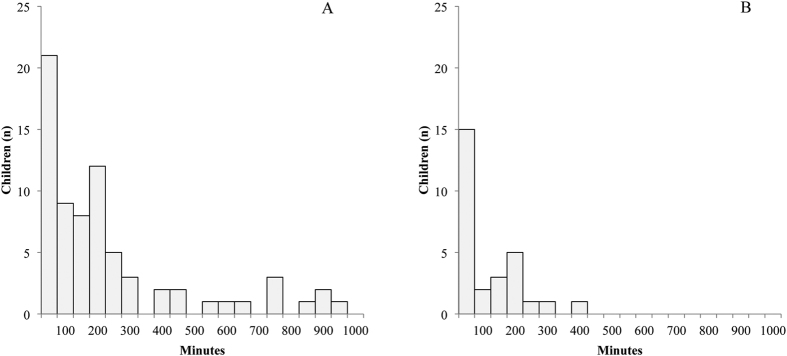
Number of children reaching high-normal and hyperglycaemic sensor glucose concentrations during specified time intervals.(A) Duration in minutes sensor glucose concentrations ≥6.7 mmol/L (n = 72; 65% of the total group) (B). Duration in minutes sensor glucose concentrations ≥7.8 mmol/L (n = 28; 25% of the total group).